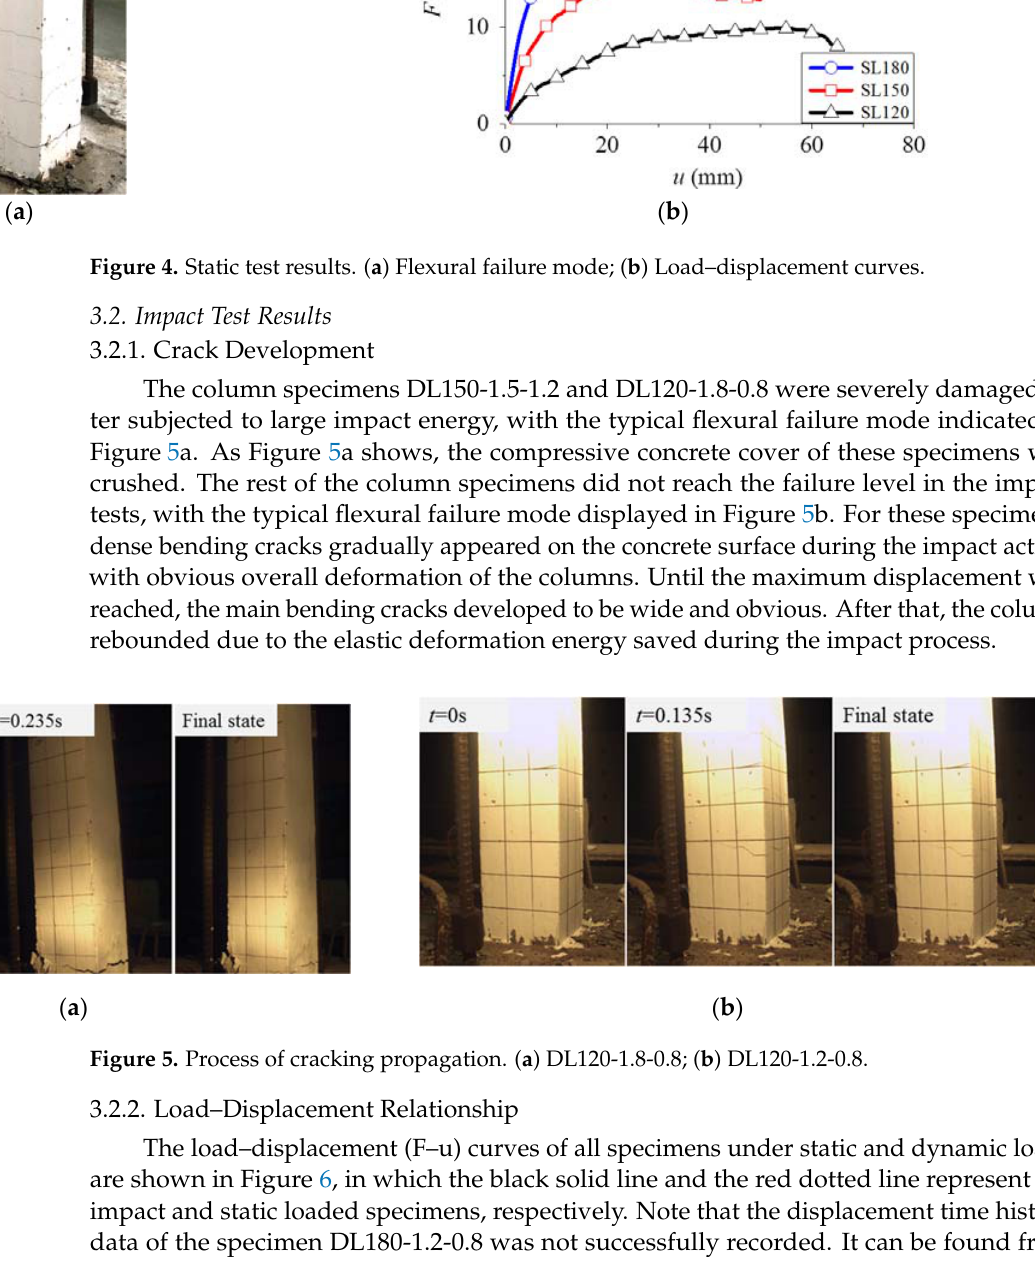
Figure 5. Process of cracking propagation. ( a ) DL120-1.8-0.8; ( b ) DL120-1.2-0.8.